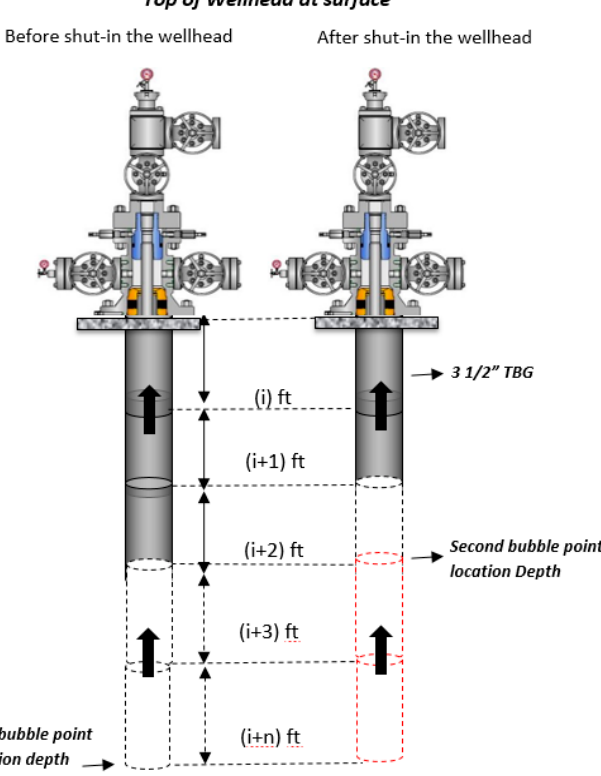
Figure 1. Schematic of the flow measurement stages in a vertical pipe before and after the well head wing valve shut-in.